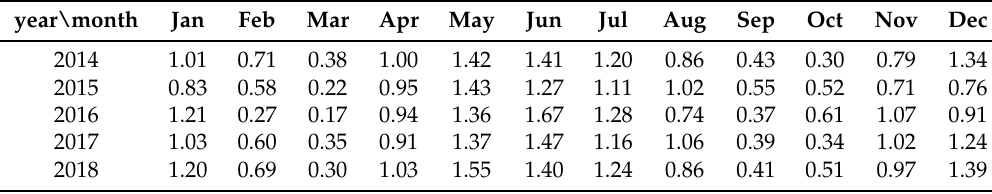
Table A4. Monthly standard deviations for surface temperature for the years